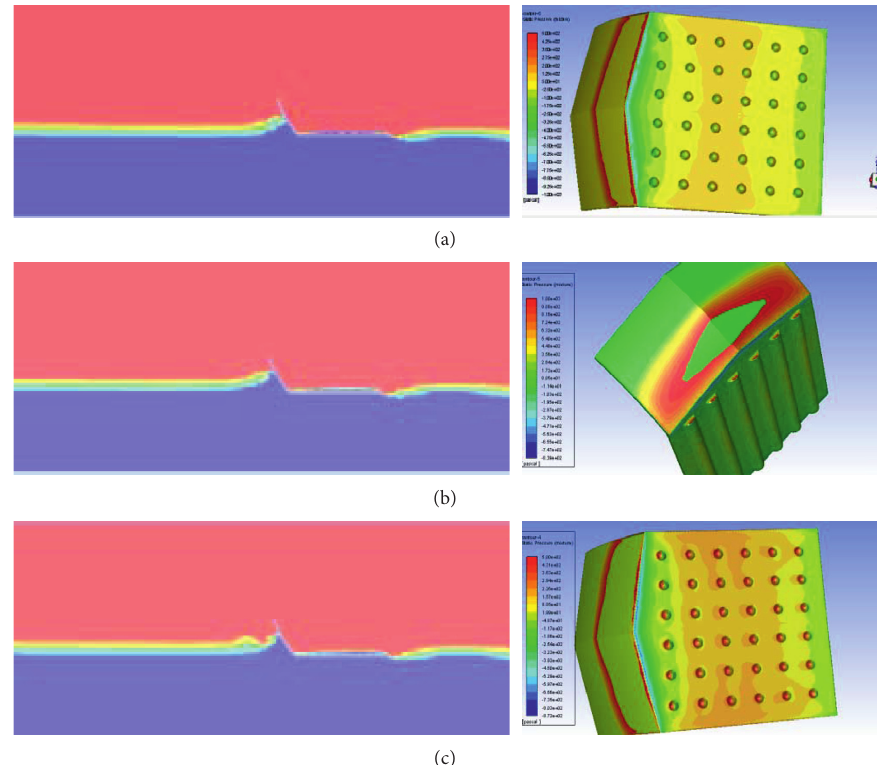
Figure 13: Hilling and pressure cloud diagram of nonsmooth bottom: (a) partial hilling and pressure cloud diagram of concave envelop, (b) partial hilling and pressure cloud diagram of groove, and (c) partial hilling and pressure cloud diagram of convex